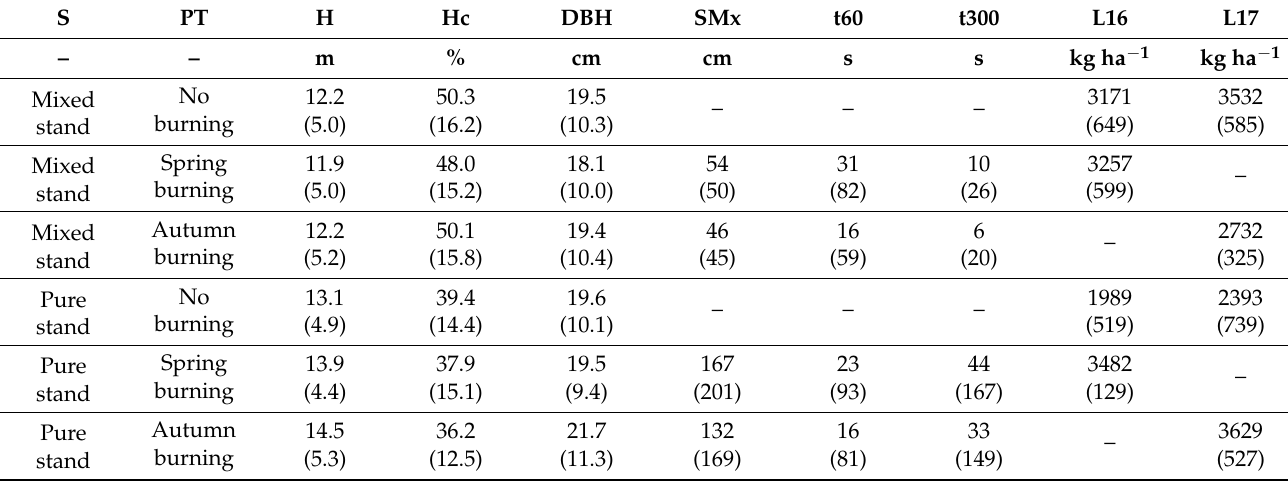
Table 4. Main variables used to model the impact of prescribed burning on tree